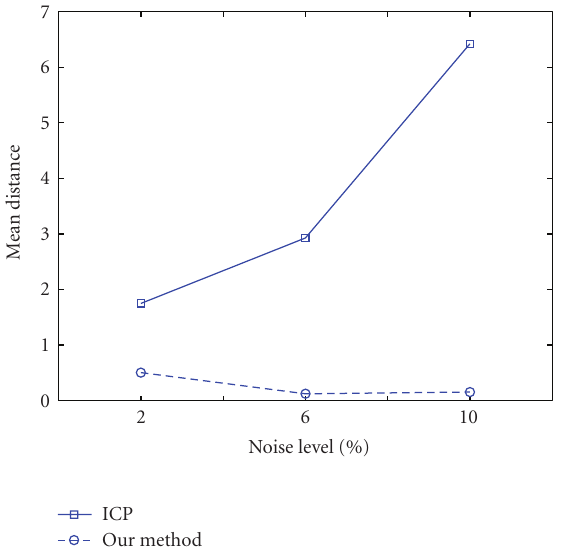
Figure 2: Comparison of mean distances between the reconstructed surface and measured data points for the 2D star example at di ff er- ent noise levels using ICP and the proposed